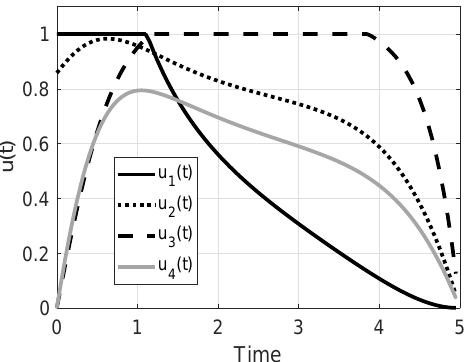
Figure 10. Case 1: evolution of the optimal control actions.